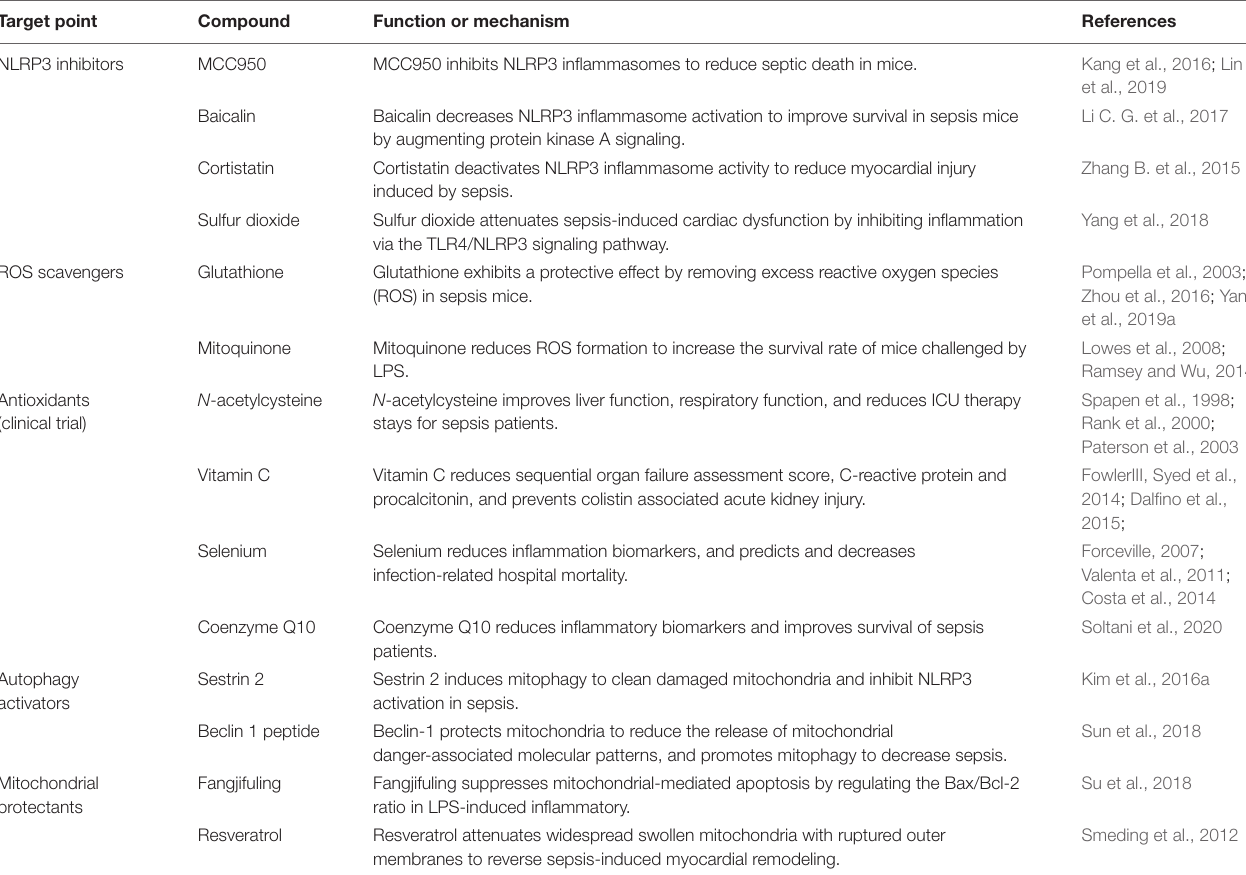
TABLE 1 | Evidence for sepsis treatment strategies by targeting NLRP3, ROS, autophagy, and mitochondria. Target